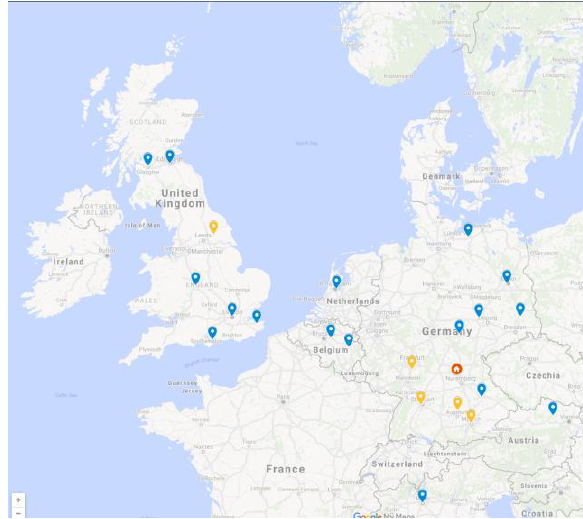
Figure 6. Higher education offers and authorities for Heritage Studies (no claim on completeness)